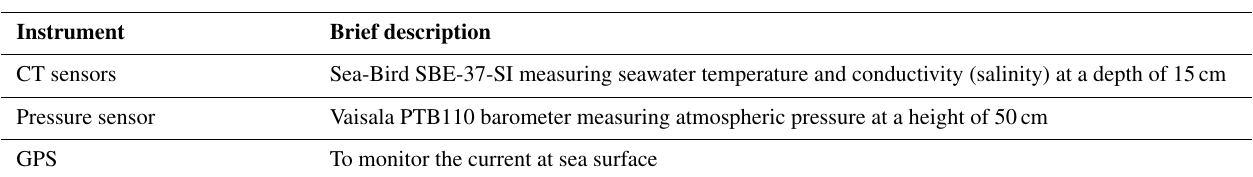
Table B29. SVP-BSC